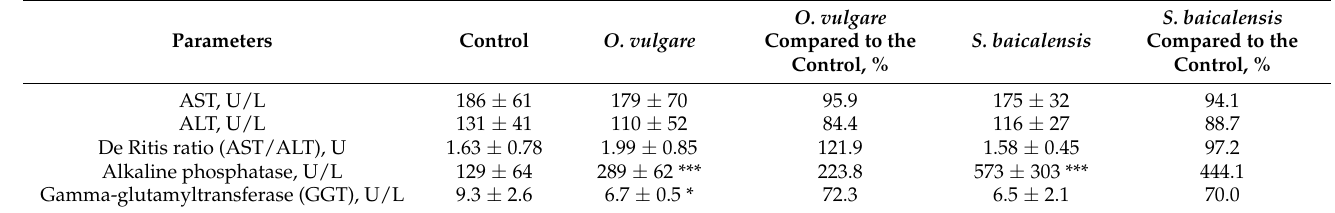
Table 5. Changes in the enzymatic activity in the blood plasma of male rats under the effects of the addition of Origanum vulgare L. and Scutellaria baicalensis Georgi to their diet (x ± SD, n = 8, duration of experiment—30